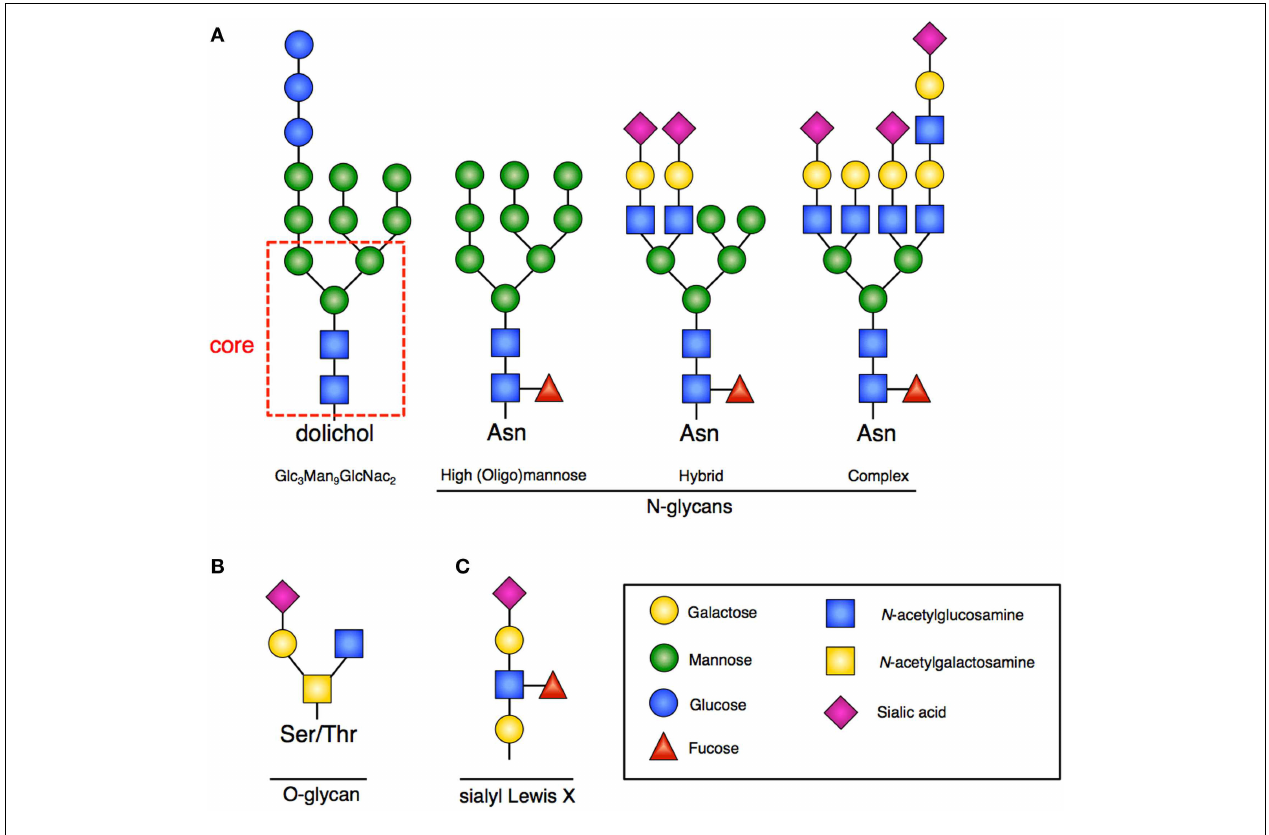
N -glycans. Increasing branching and complexity is enabled by addition of GlcNAc to the core structure. (B) Representative example of an O -glycan structure; no conserved core exists. (C) Sialyl-Lewis-X (sLex) structure that would be frequently found at the terminus of poly- N